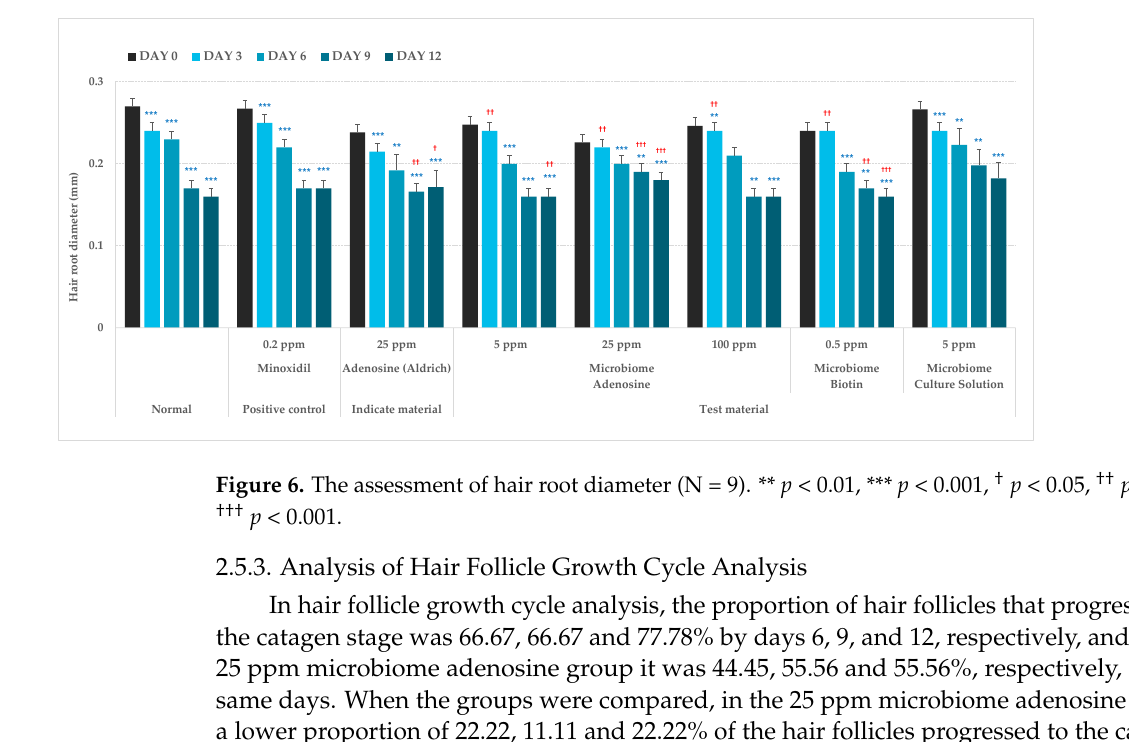
Table 1. The ratio of the number of follicle strands in the catagen phase to the hair follicle growth cycle at each time point .